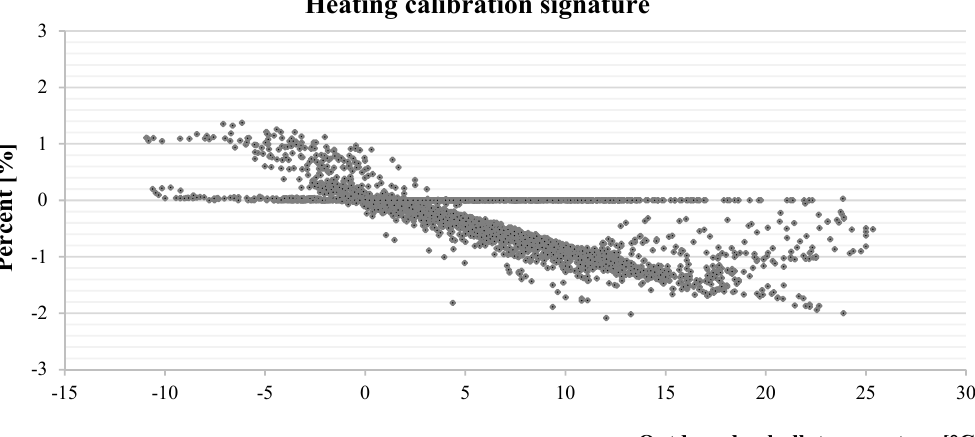
Figure 2. Example of calibration